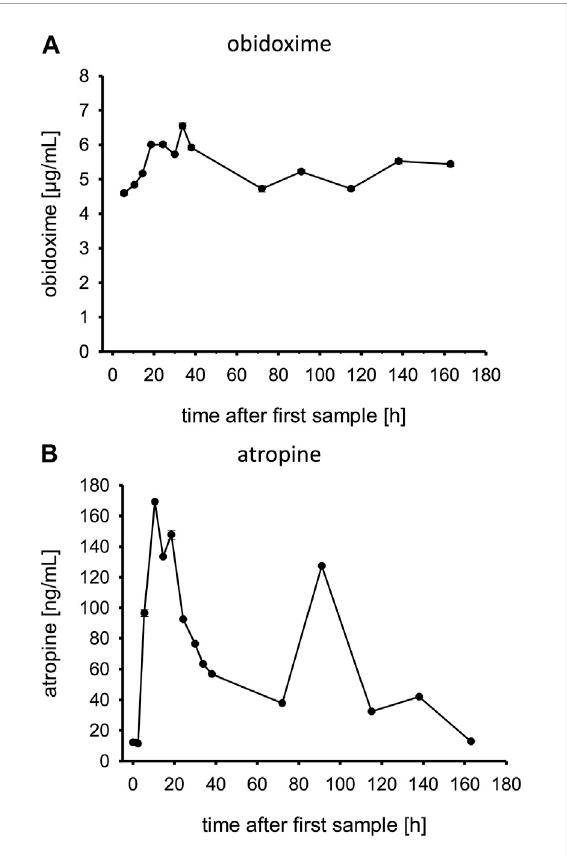
FIGURE 6 (A,B) Obidoximeandatropinelevelsinpatientplasma.Timeis shown in hours after fi rst blood sample, which was approximately upon admission to the tertiary care center